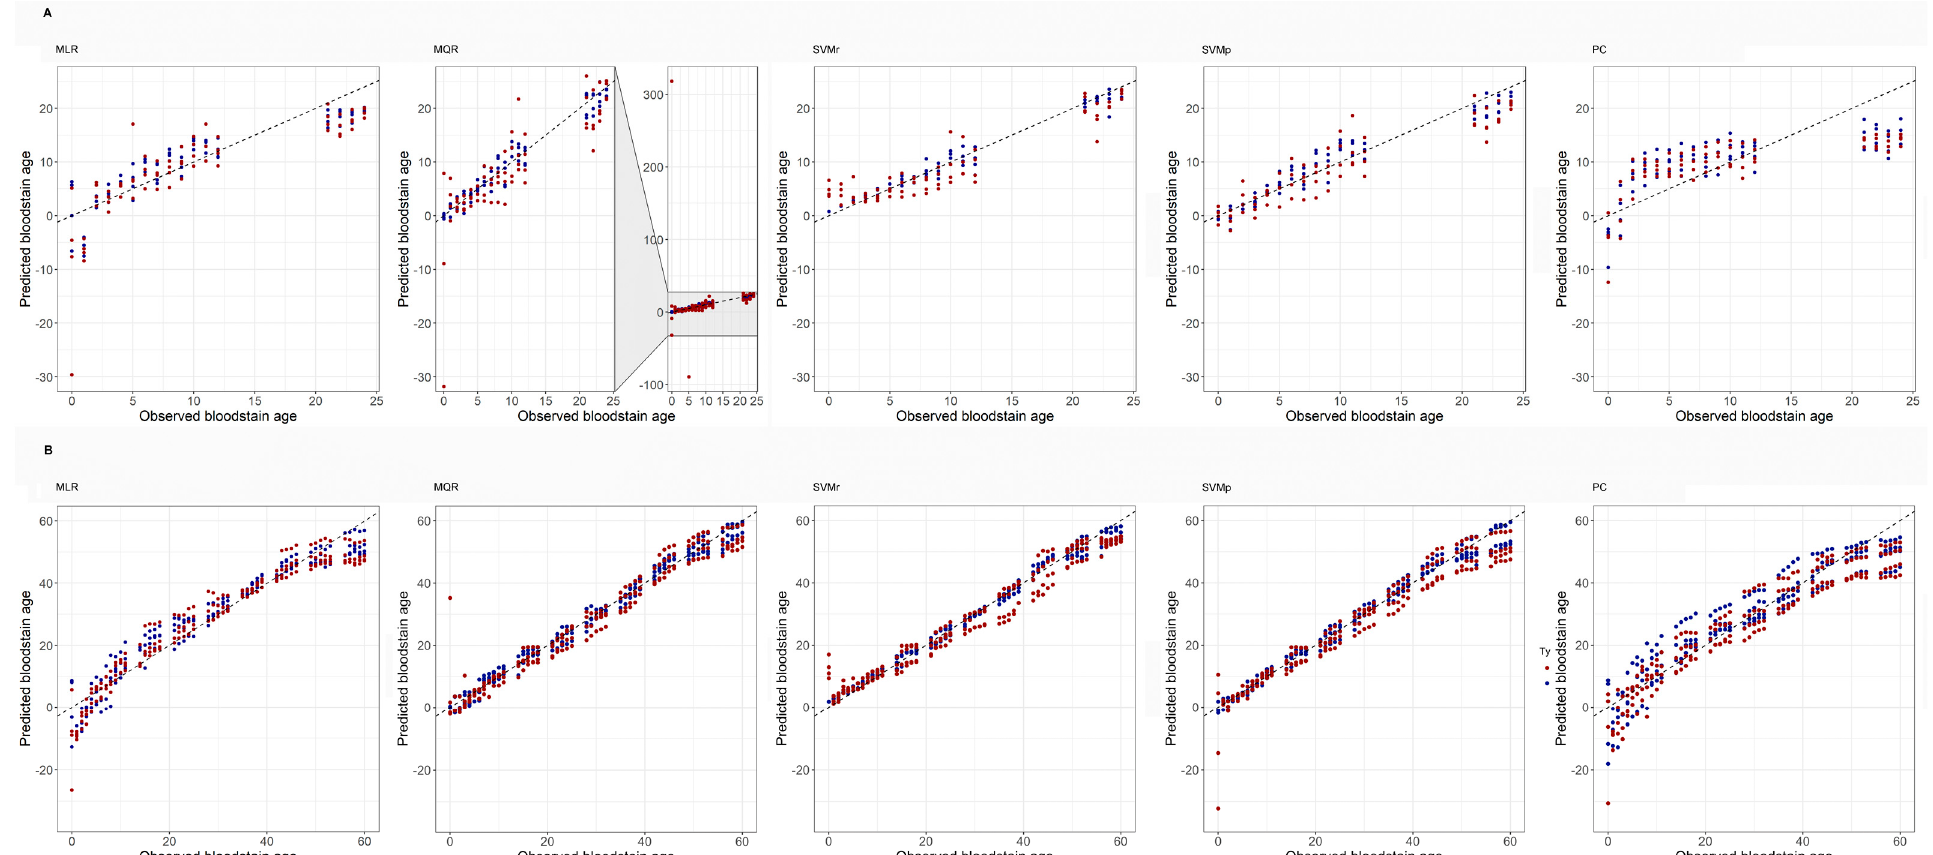
Figure 2. Scatterplots contrasting observed and predicted bloodstain ages. Each dot corresponds to a single prediction, either on the training set (blue dots) or on the test set (red dots). ( A ) Predictions generated on the short-term period (0 to 24 h). Scatterplots correspond to five ML approaches, which are, from left to right: Multiple Linear Regression (MLR); Multiple Quadratic Regression (MQR); Support Vector Machine with radial kernel (SVMr); Support Vector Machine with polynomial kernel (SVMp), and Principal Components (PC). ( B ) As in ( A ), but for the long-term period (1 to 60